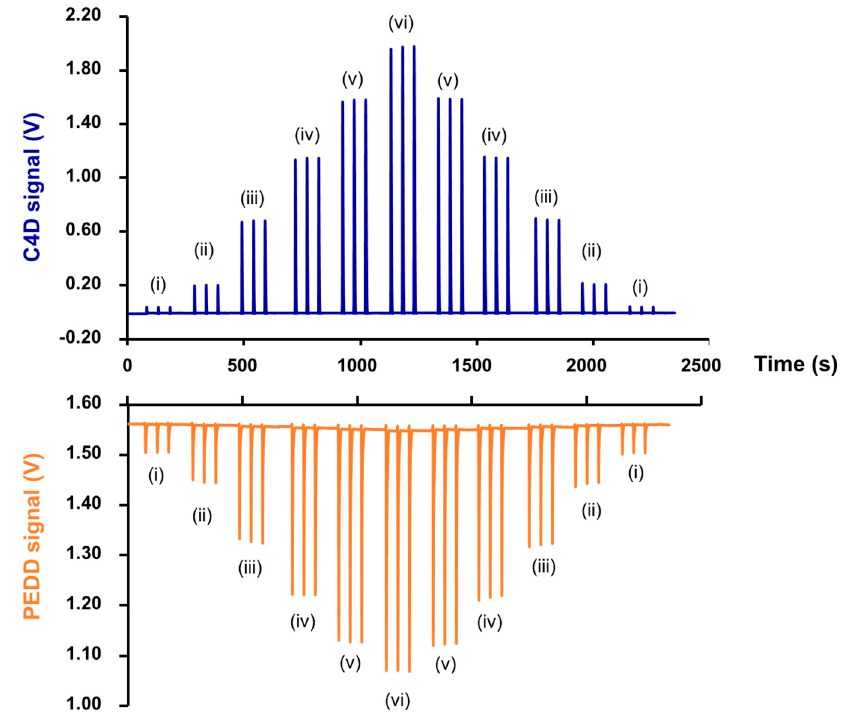
Figure 3. The series of signals recorded simultaneously by the C4D (top) and PEDD (bottom) detectors for triplicate injections of aqueous standard solutions in increasing order of concentrations and then in decreasing order, as carried out using SIA system (see Figure 2). The concentration of NaCl and the absorbance at 525 nm of orange dye in each standard solution: (i) 5 mM and 0.1124, (ii) 10 mM and 0.2228, (iii) 20 mM and 0.4466, (iv) 30 mM and 0.6657, (v) 40 mM and 0.8844 and (vi) 50 mM and 1.0332.